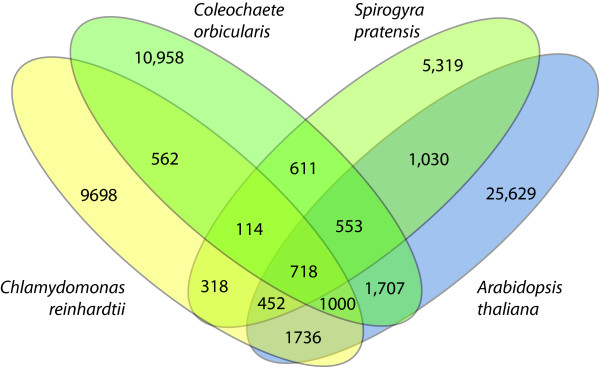
Venn Diagram. Venn diagram showing shared reciprocal best hits between the EST libraries and reverence genomes of Arabidopsis (streptophyte) and Chlamydomonas (chlorophyte). The numbers in each oval add up to the total number of unigenes (or genes) for each taxon.